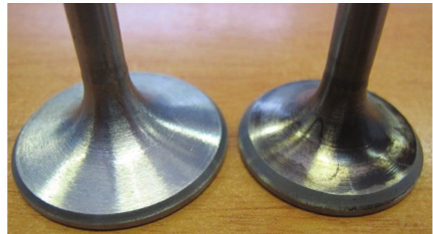
Figure 4: Healthy valves of cylinder number 4. Clearance fault was simulated by lift on valves.